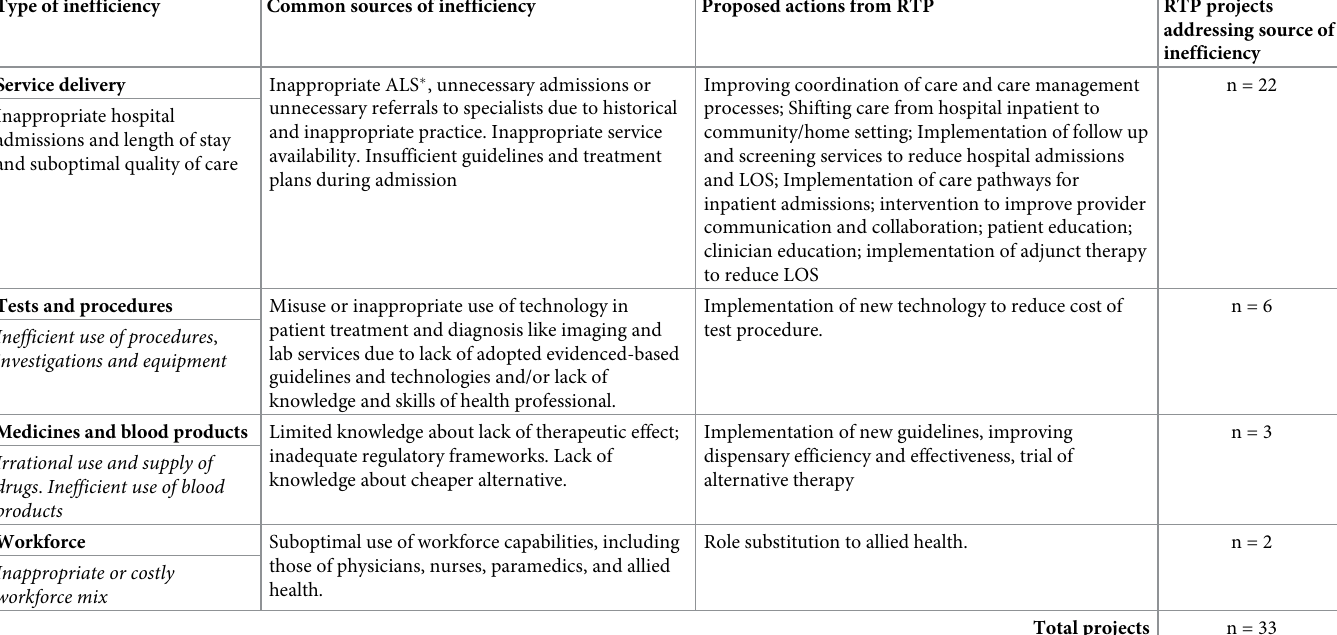
Table 4. Sources of inefficiency addressed by research translation